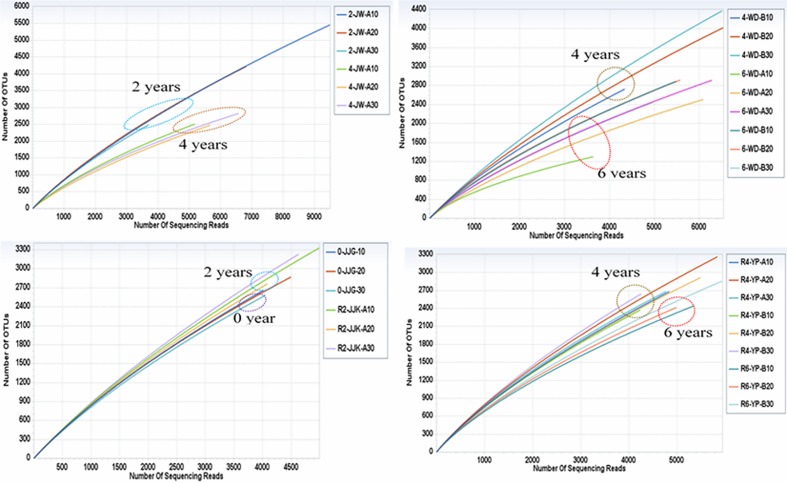
Rarefaction curves depicting the effect of sequencing on the number of operational taxonomic units (OTUs) within 30 soil samples.OTUs are shown at the 3% genetic distance levels.